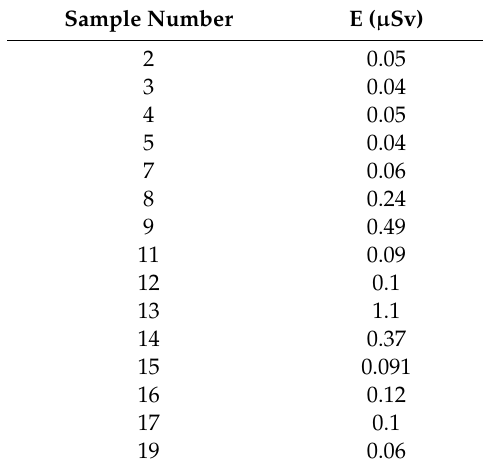
Table 5. Doses from beta and gamma radiation received after 20 half-hour